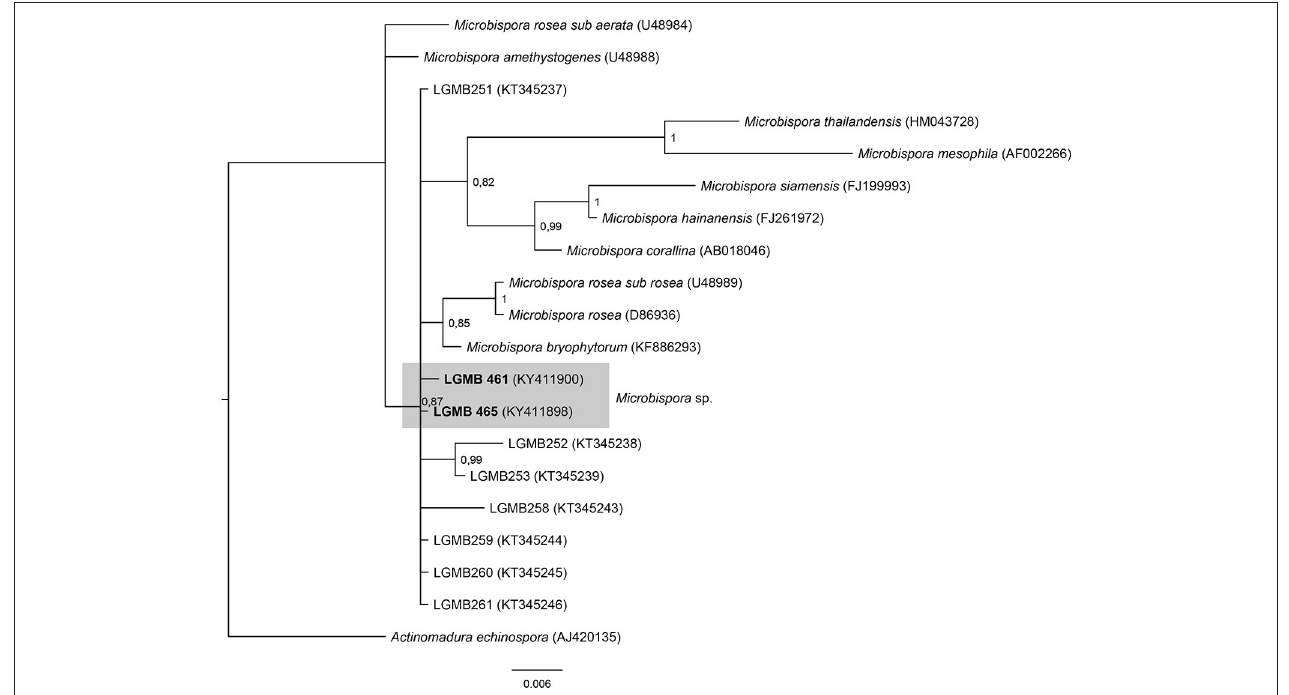
FIGURE 4 | Bayesian phylogenic tree based on 16S rRNA gene of LGMB461, LGMB465, the 10 type strain of Microbispora genus, and 7 strains previously reported by Savi et al. (2016). Values on the node indicate Bayesian posterior probabilities. The species Citricoccus parietis was used as out group. Scale bar indicates the number of substitutions per site.